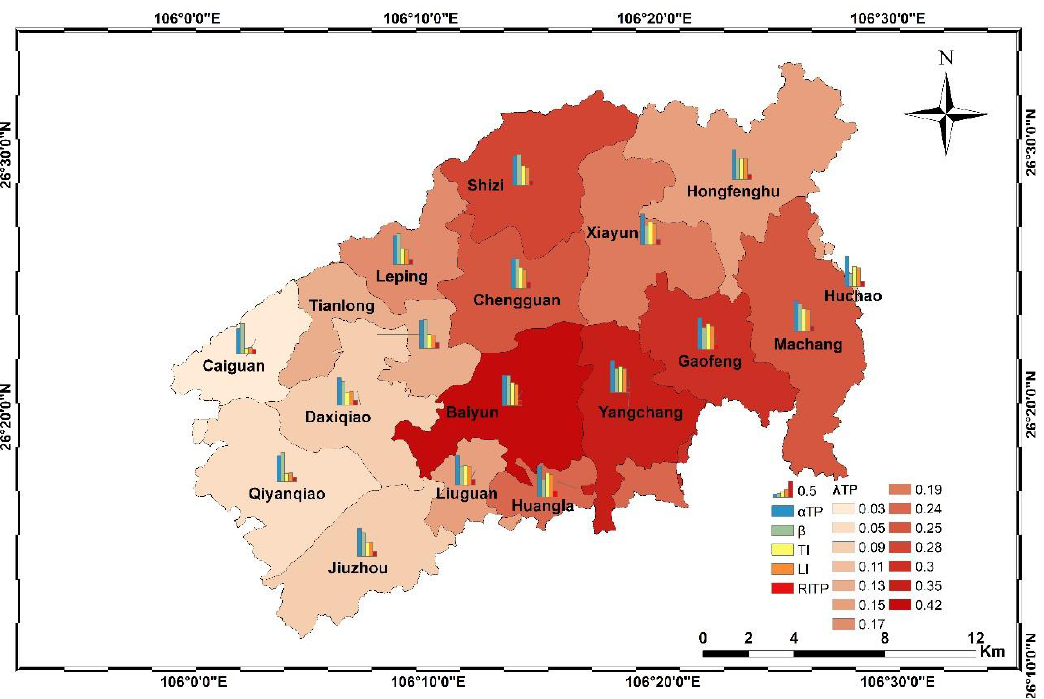
Figure 7. PTRE – NPS of TP at the town scale in the Hongfenghu reservoir watershed.